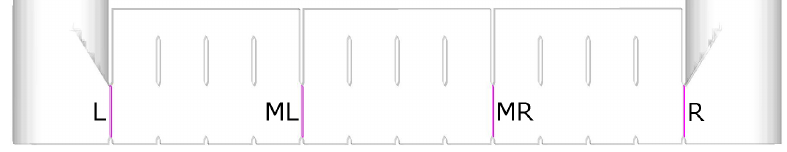
Figure 4. Flux planes for logging of particle mass fluxes, as set in Barracuda